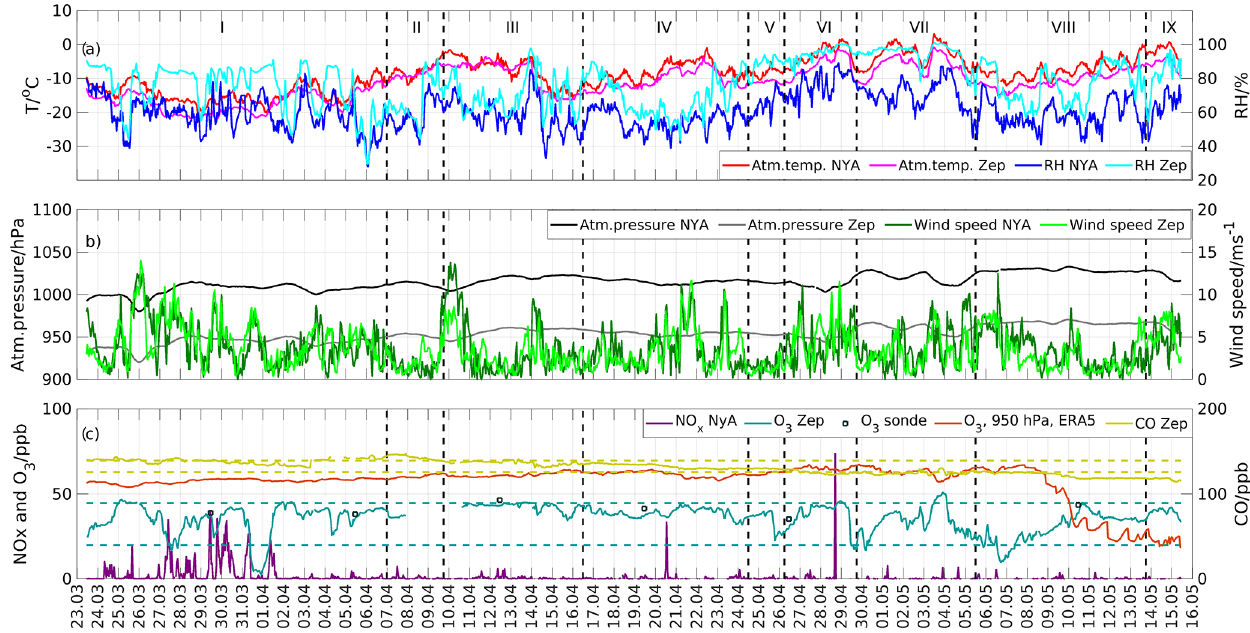
Figure 2. (a) The hourly average air temperature and relative humidity measured in Ny-Ålesund (NYA) and at the Zeppelin station (Zep). (b) Atmospheric pressure and wind speed measured in Ny-Ålesund and at the Zeppelin station. (c) NO x , CO and O 3 concentrations in Ny-Ålesund, at the Zeppelin station and in the ERA5 reanalysis for the nearest grid point the coordinates of Ny-Ålesund for the period from 23 March to 16 May 2017. The dashed black lines represent time frames of the different weather regimes. The dashed blue line shows 5th and 95th quantiles of the O 3 concentration.